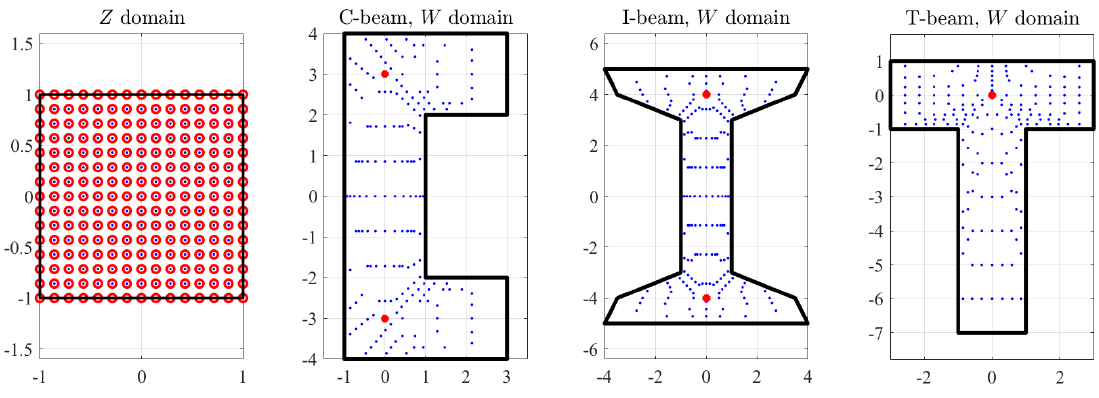
Figure 3. Examples of projection mapping for “C”, “I”, and “T” beam shape domains. Table 1. Control points for the “T” beam shape